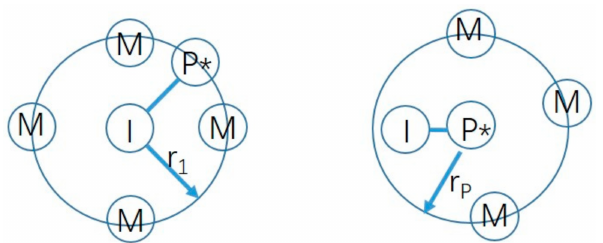
Figure 1. Schematic representation of the initiation step of the polymerization (left and center diagrams), as well as the chain propagation (right) (I is the initiator, P* is the active center of the growing chain, M is the unreacted monomer, r l is the radius of initiation, and r p is the radius of propagation)